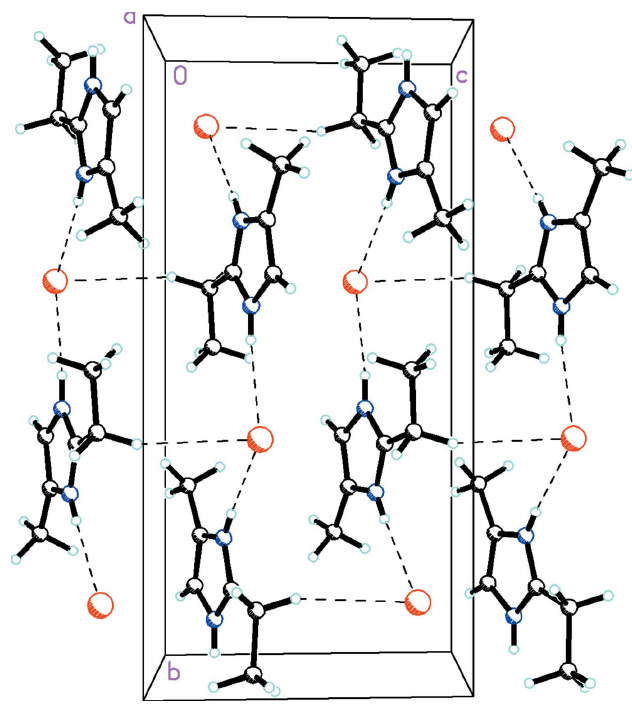
Figure 2 Packing diagram of 1 viewed down [100] showing how the cations and anions are linked into C (8)chains propagating in the b -axis direction.